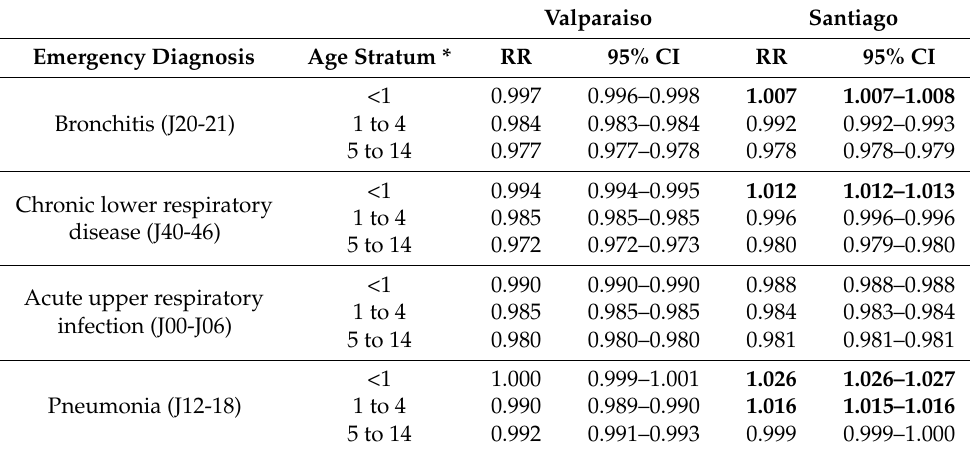
Table 2. Associations among wildfires on respiratory emergencies in Valparaiso y Metropolitan region from 2010 to 2013 (as Relative Risk and Confidence Interval at 95%) . Model for emergency diagnosis according to PM10 and number of fires, adjusted for variable meteorological variables (temperature and precipitations).